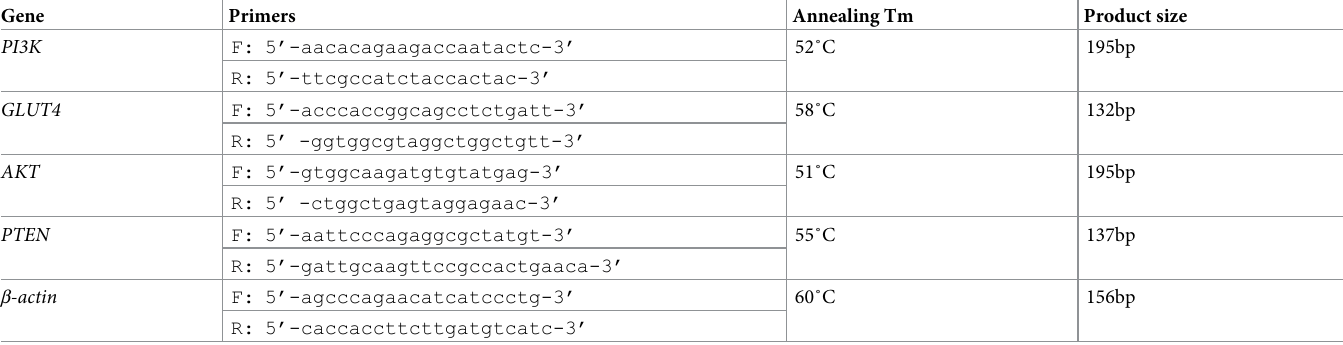
Table 1. Primer sequences employed for reverse transcription-quantitative polymerase chain